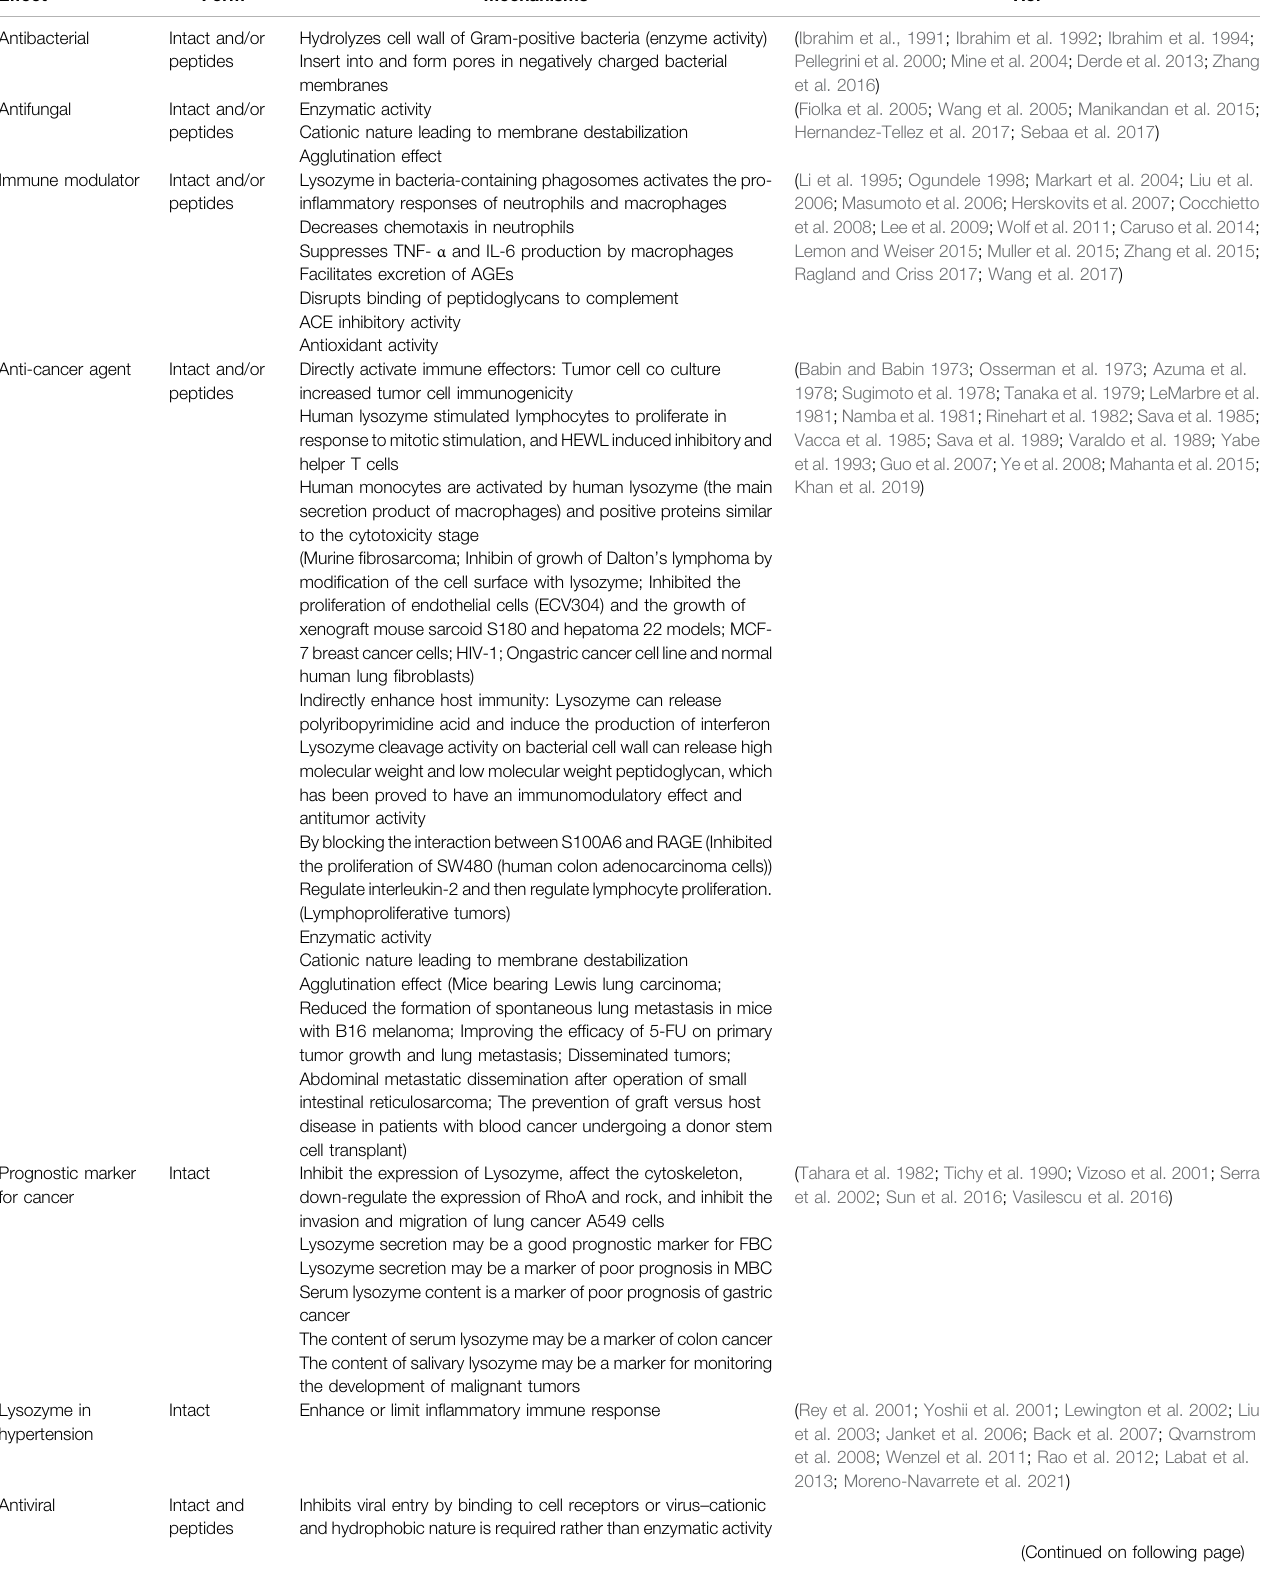
TABLE 2 | The role of lysozyme in